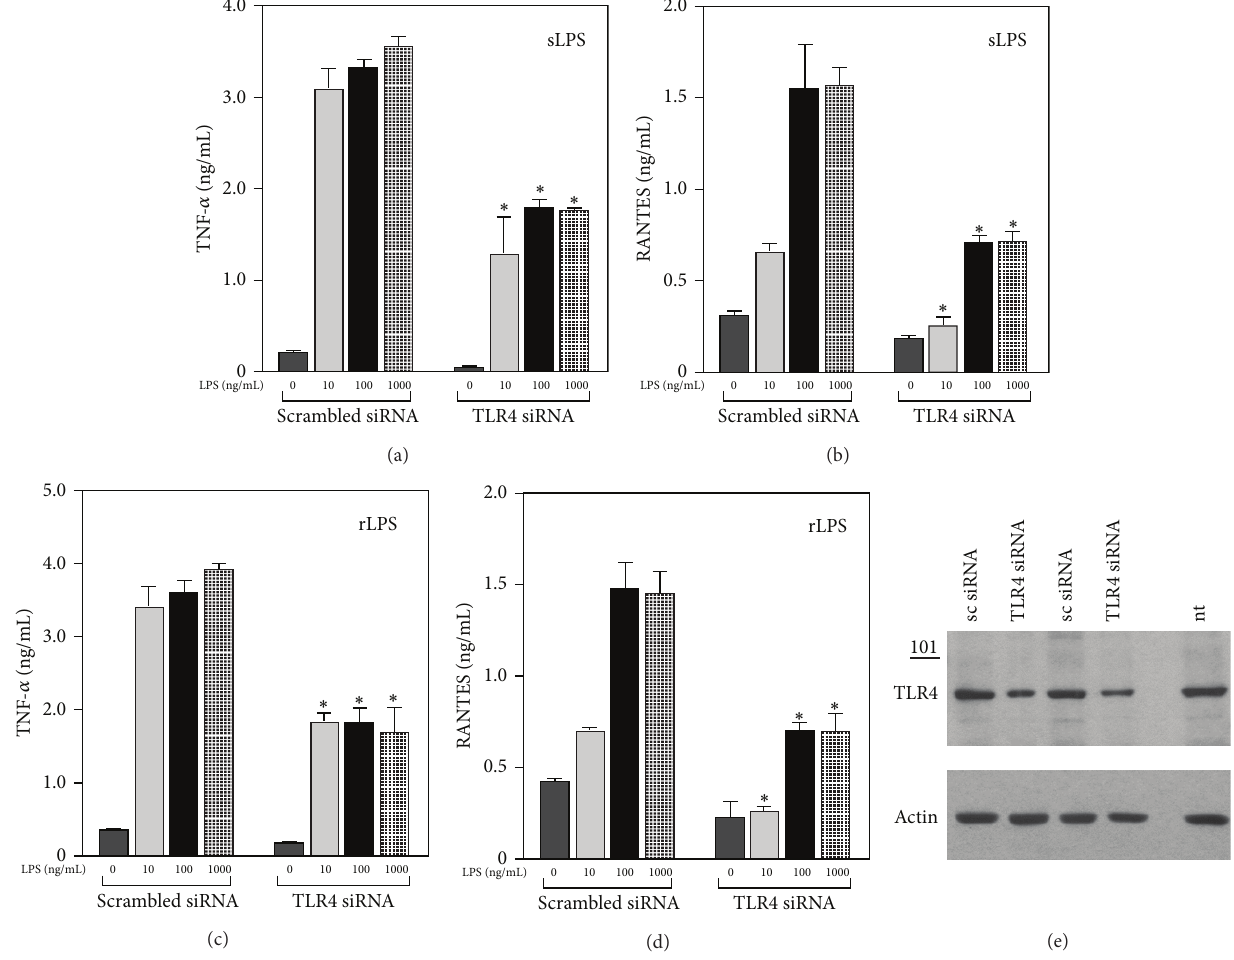
Figure 2: Silencing of TLR4 gene expression significantly downregulates production of TNF- 𝛼 and RANTES in cells stimulated with sLPS or rLPS. RAW264 cells were transfected with TLR4-specific siRNA or scrambled siRNA and, after 50 h, stimulated with 10–1000ng/mL sLPS (a, b) or 10–1000ng/mL rLPS (c, d). Production of TNF- 𝛼 (a, c) and RANTES (b, d) by the cells was estimated by ELISA tests. Data shown are mean ± SEM from three experiments each run in triplicate. ∗ Significantly different from cells treated with scrambled siRNA and stimulated with a corresponding LPS concentration. (e) Immunoblotting analysis of TLR4 protein level versus actin level in cells transfected with TLR4- specific or scrambled (sc) siRNA. nt: not transfected cells. On the left, a molecular weight marker (prestained phosphorylase b, 101kDa) is indicated. Data from two independent experiments are